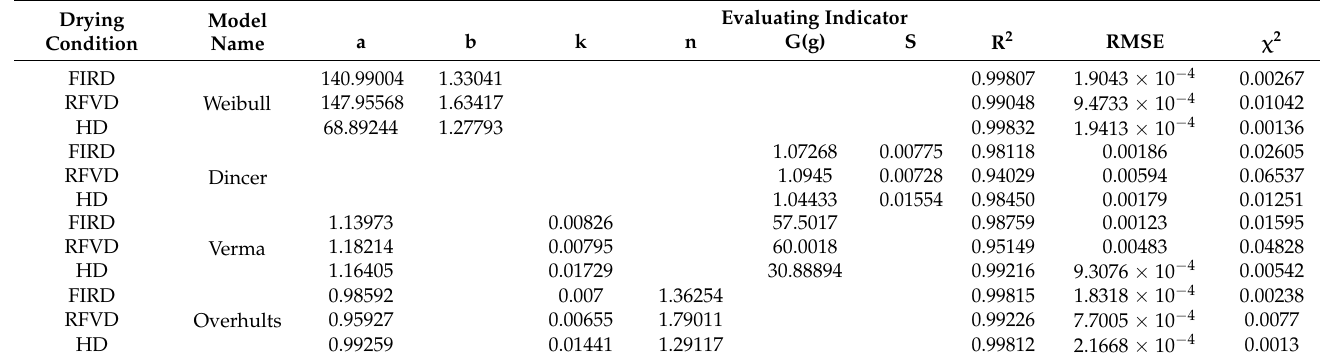
Table 3. Model fitting